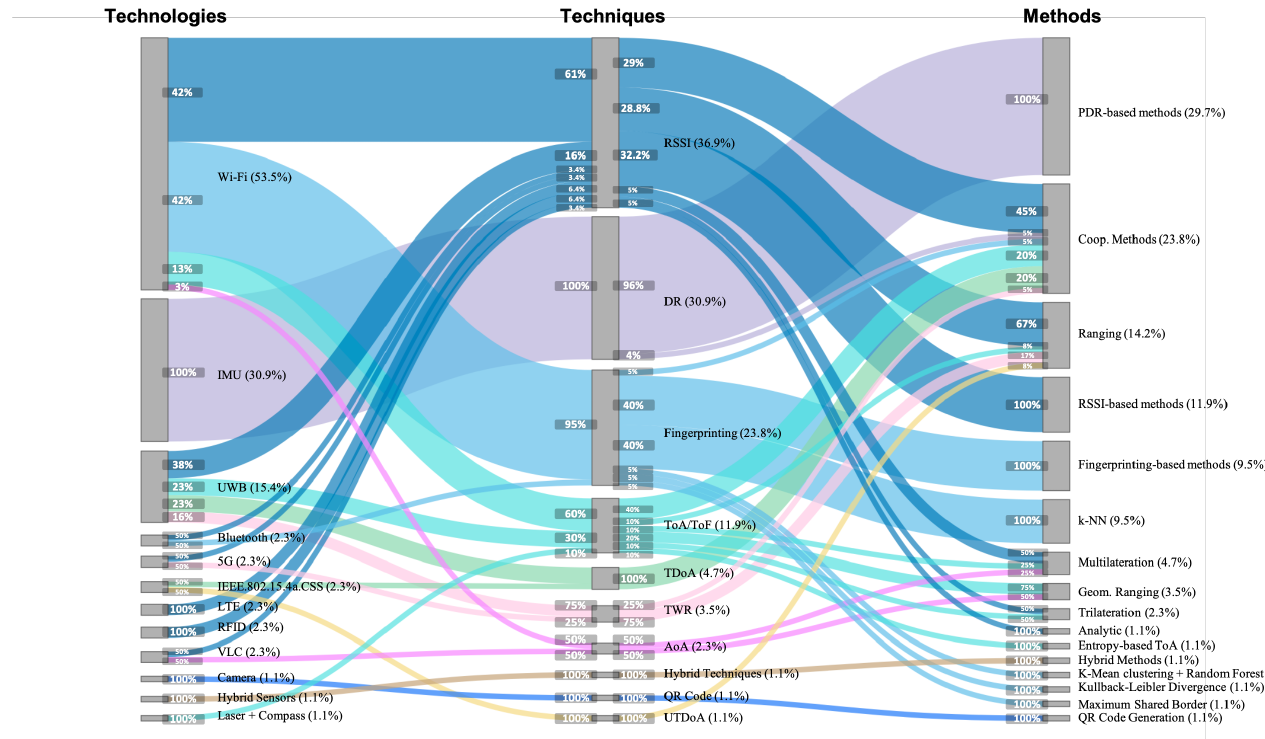
Figure 5. Non-collaborative technologies, techniques, and methods in CIPS. Source: Authors.